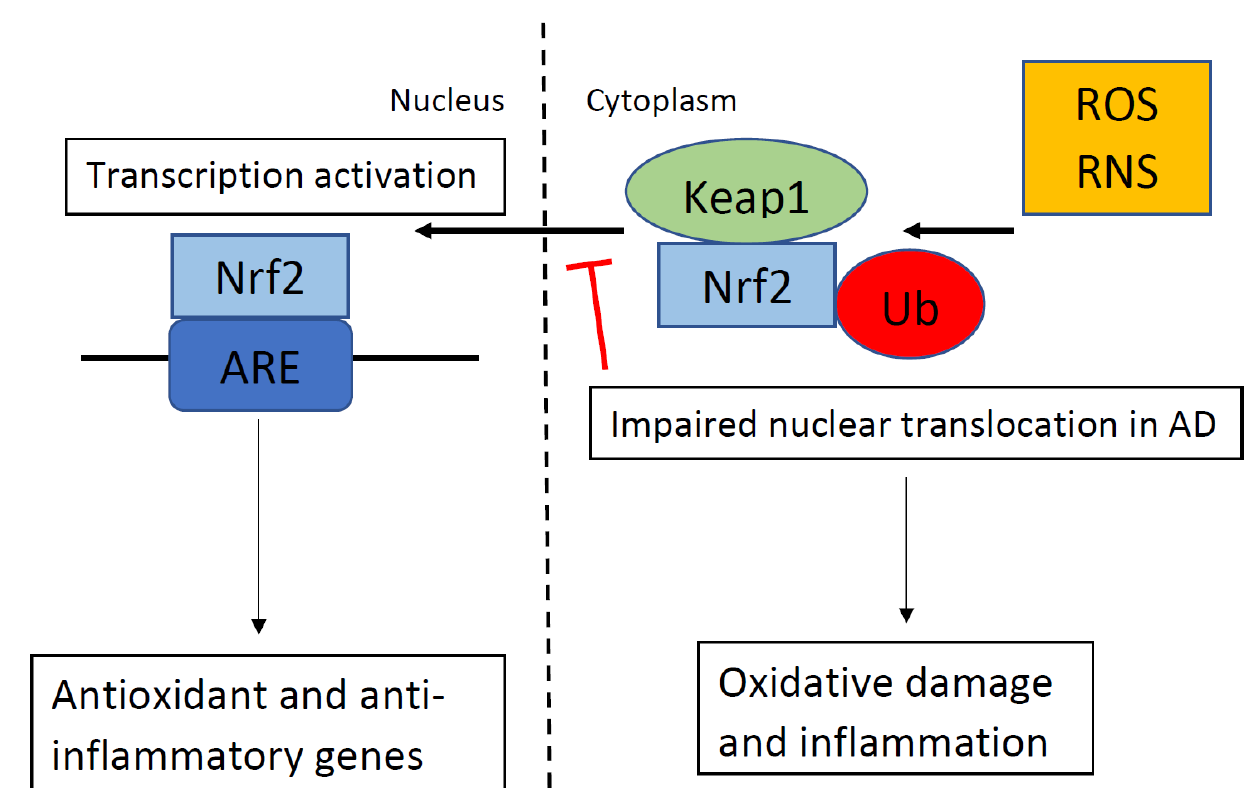
Figure 1. In the absence of oxidative stress. Kelch-like ECH-associating protein 1 (Keap1) suppresses the activation of nuclear factor erythroid 2-related factor 2 (Nrf2) and targets Nrf2 for ubiquitination (Ub). When Keap1 detects oxidative stress via reactive oxygen species (ROS) or reactive nitrogen species (RNS), as shown in the top right portion of the figure, Keap1 ends the inhibition of Nrf2, and Nrf2 translocates into the nucleus. Nrf2 binds to the antioxidant response element (ARE), which regulates the expression of antioxidant and anti-inflammatory genes. In Alzheimer’s disease (AD), nuclear translocation in response to ROS/RNS is impaired, which results in oxidative damage and inflammation.